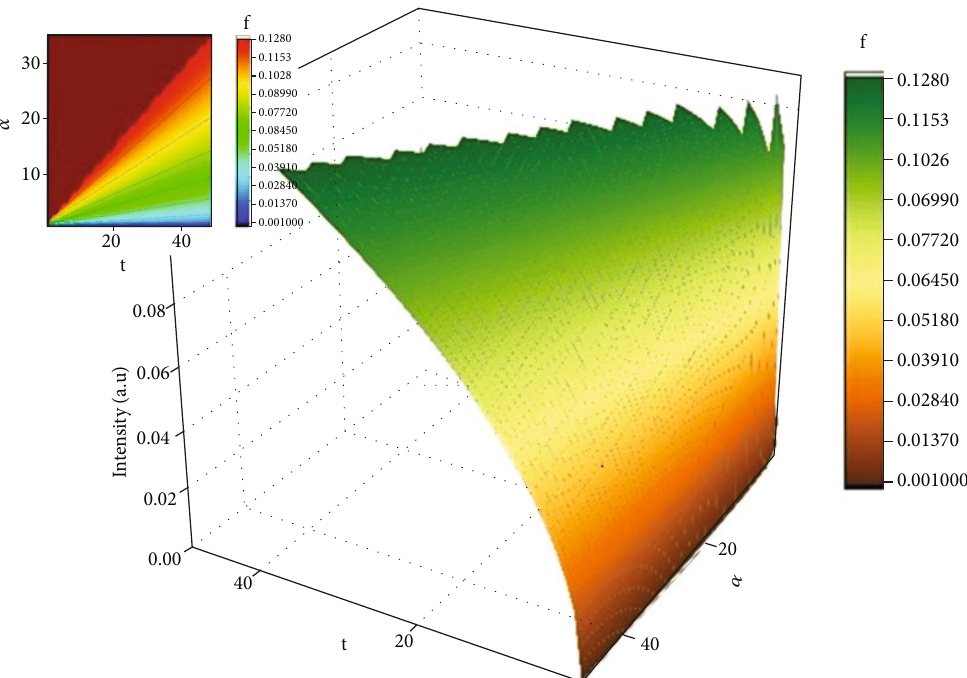
Figure 4: 3D (left side) and contour plot (right side) representations of the multifractal function used for drug release mechanism analysis.